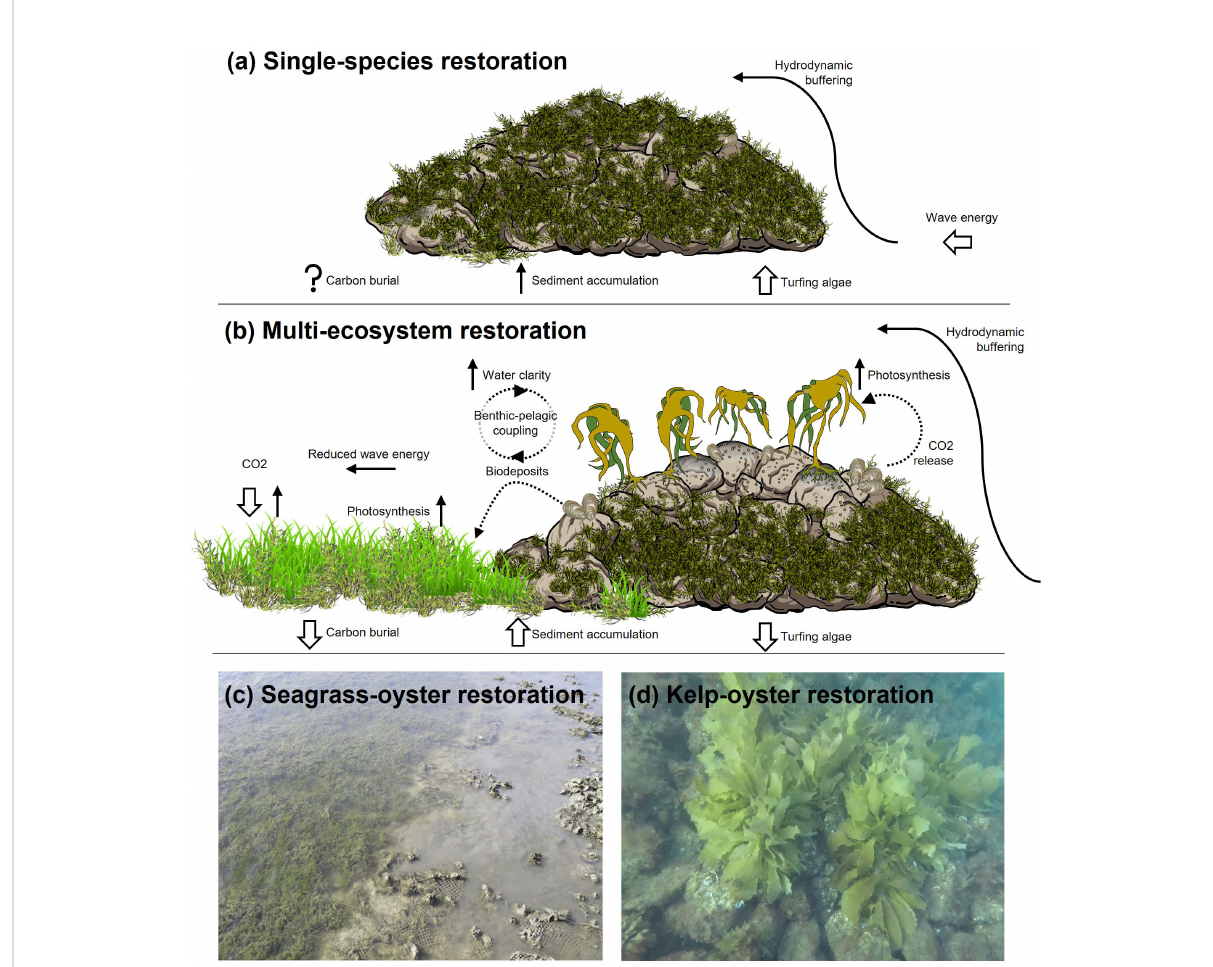
FIGURE 1 Restoration practice commonly focuses on (a) single-species approaches to habitat restoration, such as constructing reefs to restore oysters, whereas a (b) multi-habitat approach could utilise constructed reefs to recover multiple lost habitat-types (oysters, seagrass, kelp). Examples of multi-habitat restoration in practice demonstrate the facilitative bene fi ts of co-restoration, including (c) constructed oyster reefs that buffer hydrodynamics and stabilise sediments to promote seagrass recovery (adapted from Milbrandt et al., 2015 with permission from Elsevier), and (d) kelp transplants atop constructed reefs that maintain substrata free of tur fi ng algae to facilitate understory oyster recruitment (South